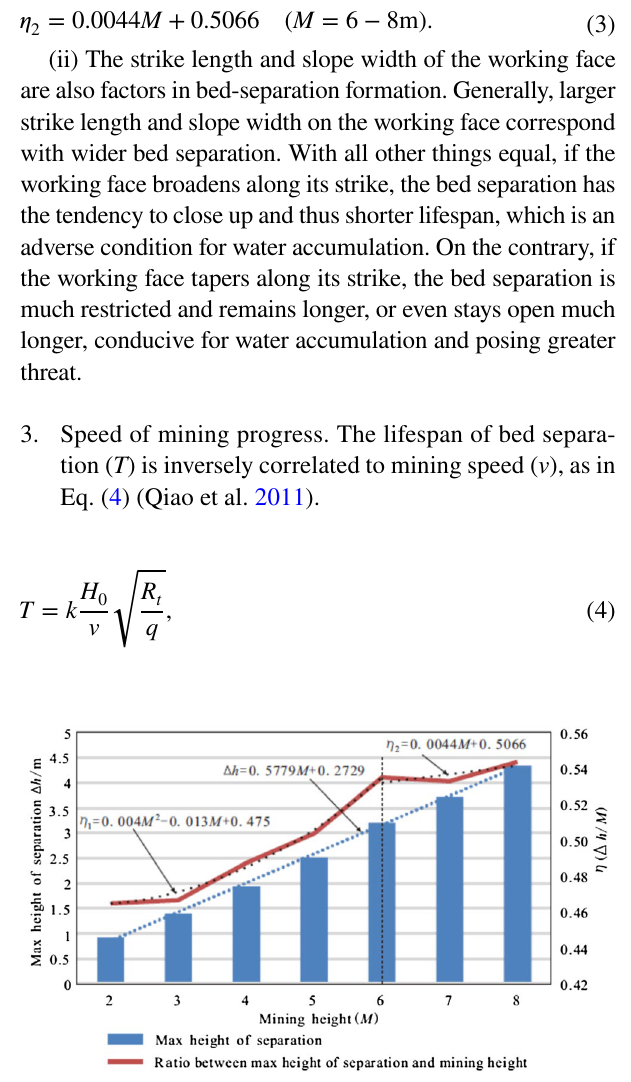
Fig. 3 Relations between the maximum bed-separation height ( △ h ), mining height ( M ), and ratio between the